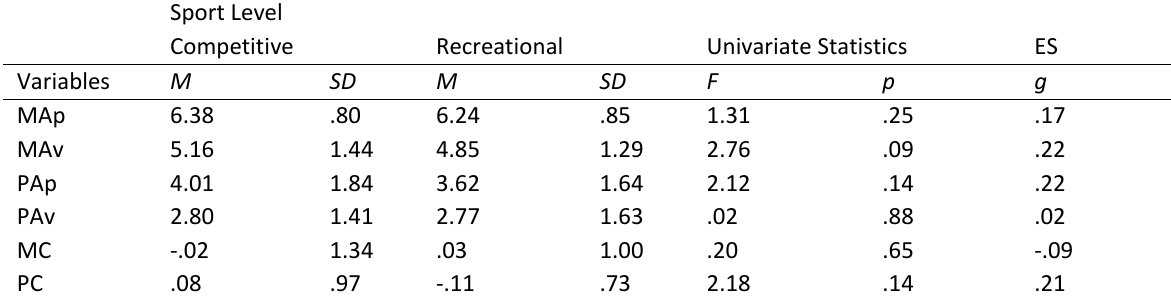
Table 3. Means, standard deviations, univariate statistics, and effect size values for the sport level Sport